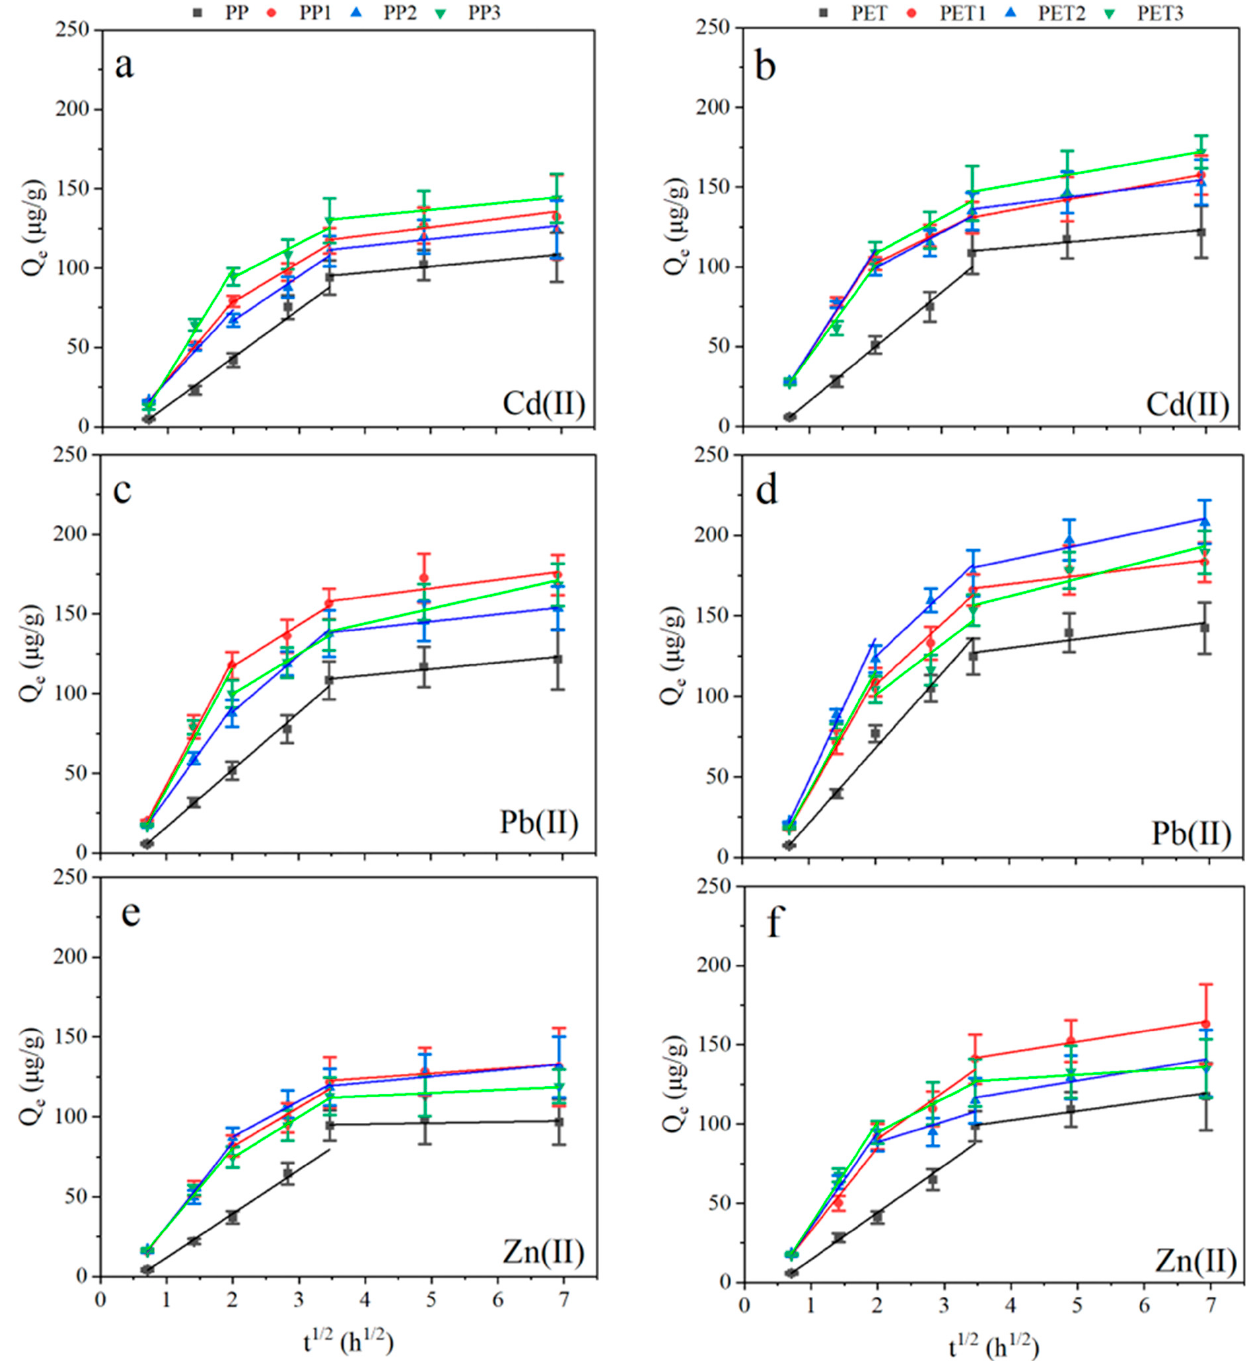
Figure 6. Intraparticle diffusion curves of Cd(II) ( a , b ), Pb(II) ( c , d ) and Zn(II) ( e , f ) for plastic debris. PP and PET: virgin plastic; PP1 and PET1: biofilm-covered plastic in Xuanwu Lake; PP2 and PET2: biofilm-covered plastic in Donghu Lake; PP3 and PET3: biofilm-covered plastic in the Qinhuai River.